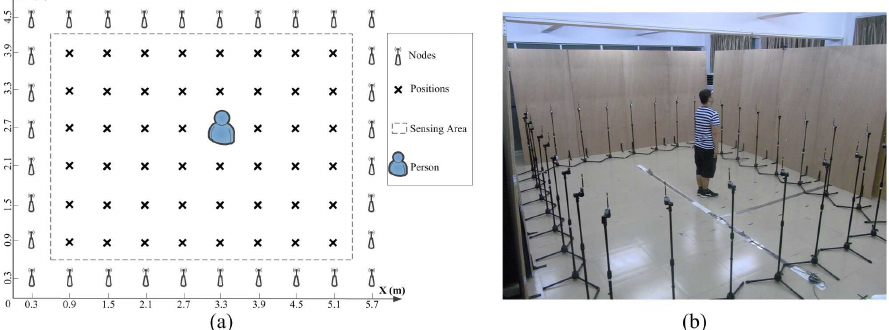
Figure 4. Experimental setup in indoor line-of-sight (LOS) scenario. ( a ) Geography map; ( b ) prototype of the radio tomography